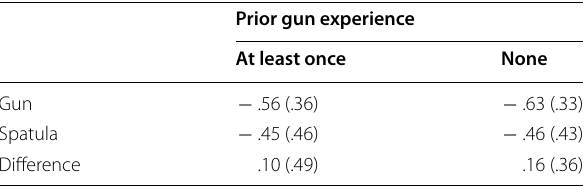
Table 3 B ″ scores (and between-subjects